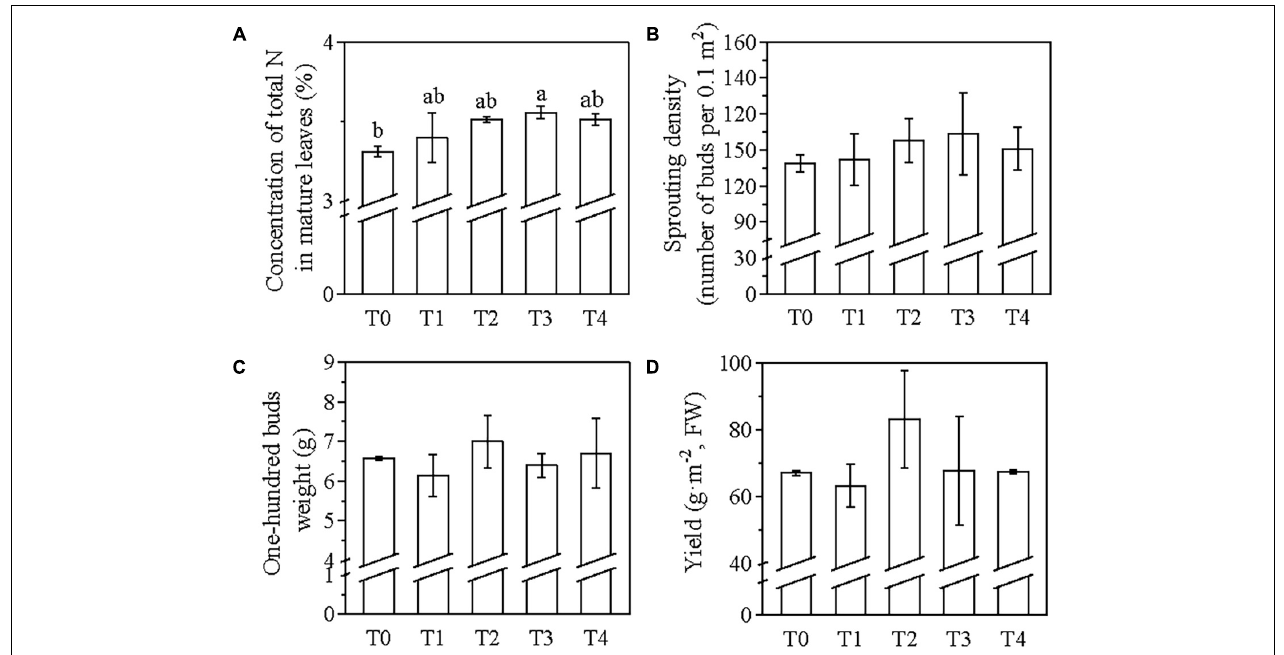
FIGURE 1 | The effect of foliar N application times at the winter dormancy stage of tea plants on the total N concentration of the mature leaves (A) , sprouting density (B) , 100 buds weight (C) , and yield of spring tea (D) . A commercially available amino acid liquid fertilizer was applied to the tea plants one time (T1), two times (T2), three times (T3), or four times (T4); no foliar application of N (T0) was used as a control. The values were shown as means ± standard errors (SEs) ( n = 3 or 4). The significance of the different foliar N application times was evaluated using one-way ANOVA followed by a Duncan test at a significance level of P 0 . 05 in the SPSS 22.0 software. Statistically significant differences ( P < 0.05) among treatments were shown with a lower case letter displayed above the bar plot. There was no significant difference for sprouting density (B) , 100 buds weight (C) , and yield (D) of spring tea under different application times of foliar N at the winter dormancy stage. FW, fresh